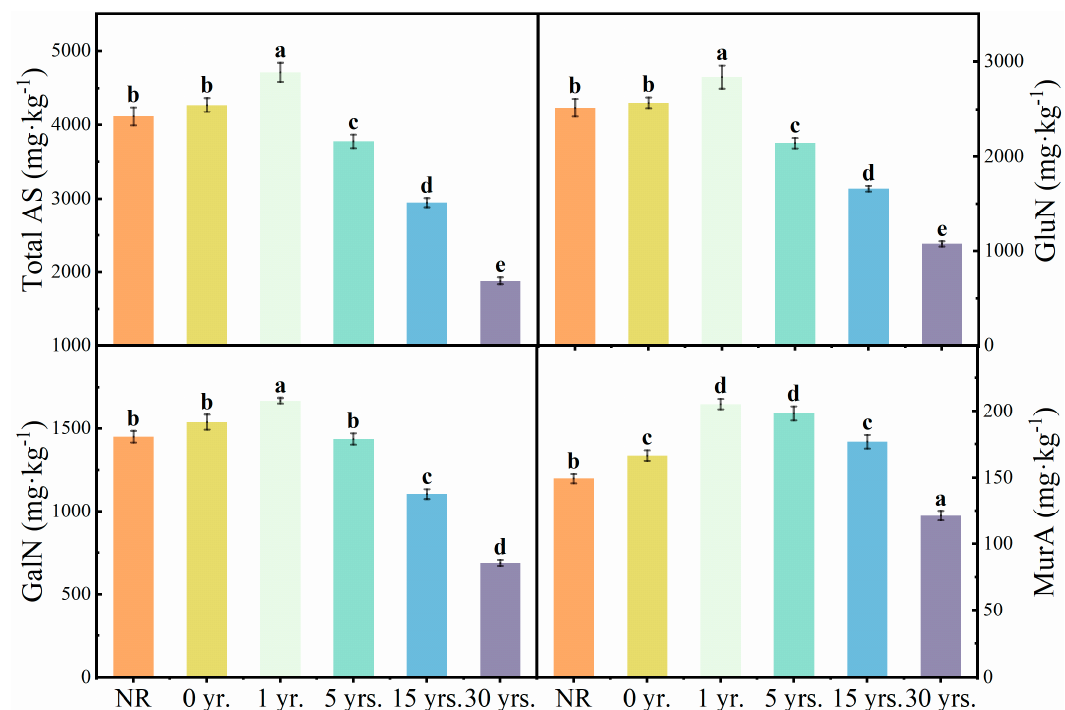
Figure 2. Changes of soil total ASs and individual AS contents of NR and cultivated land. Note: Different letters indicate significant difference among the land use types at p < 0.05.